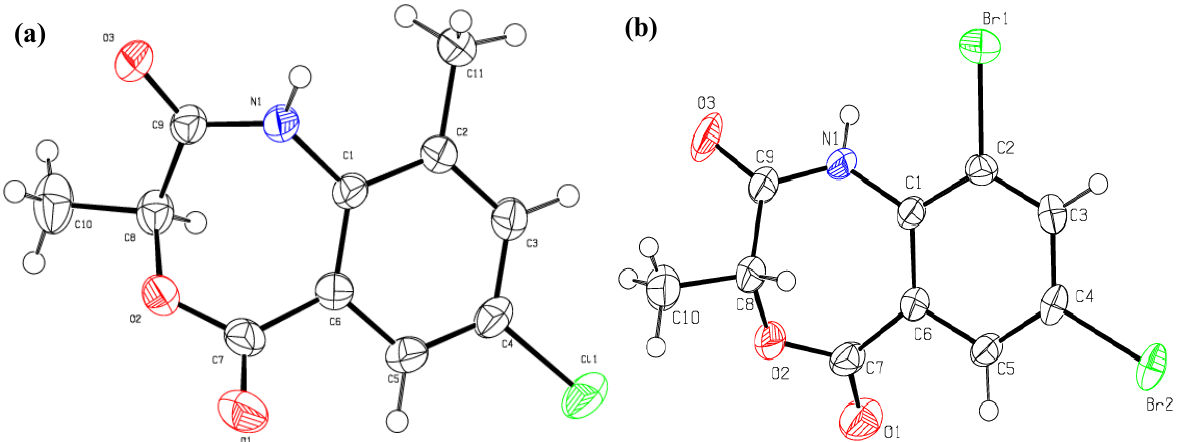
Figure 2. The ORTEP diagram of; ( a ) 4c ; ( b ) 4a